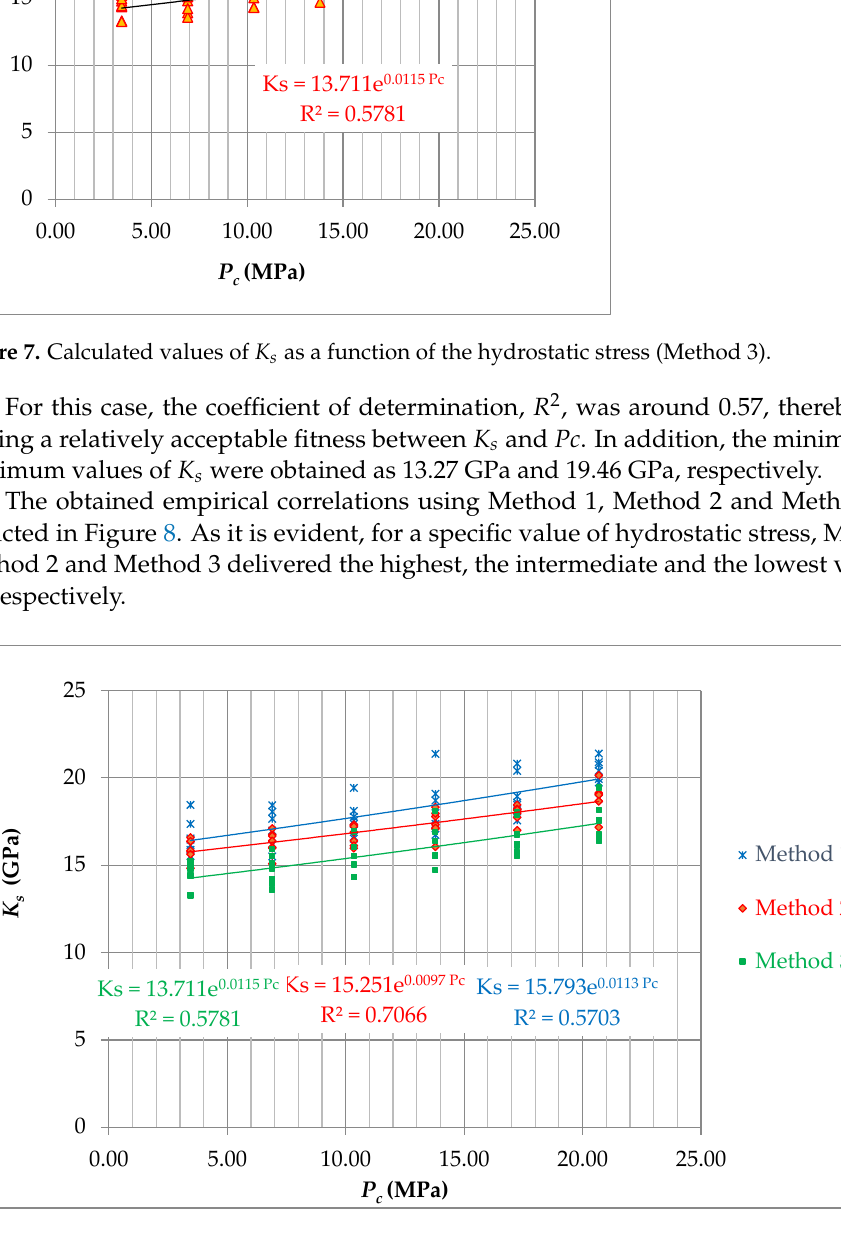
Figure 6. Calculated values of 𝐾 𝑠 as a function of the hydrostatic stress (Method 2).